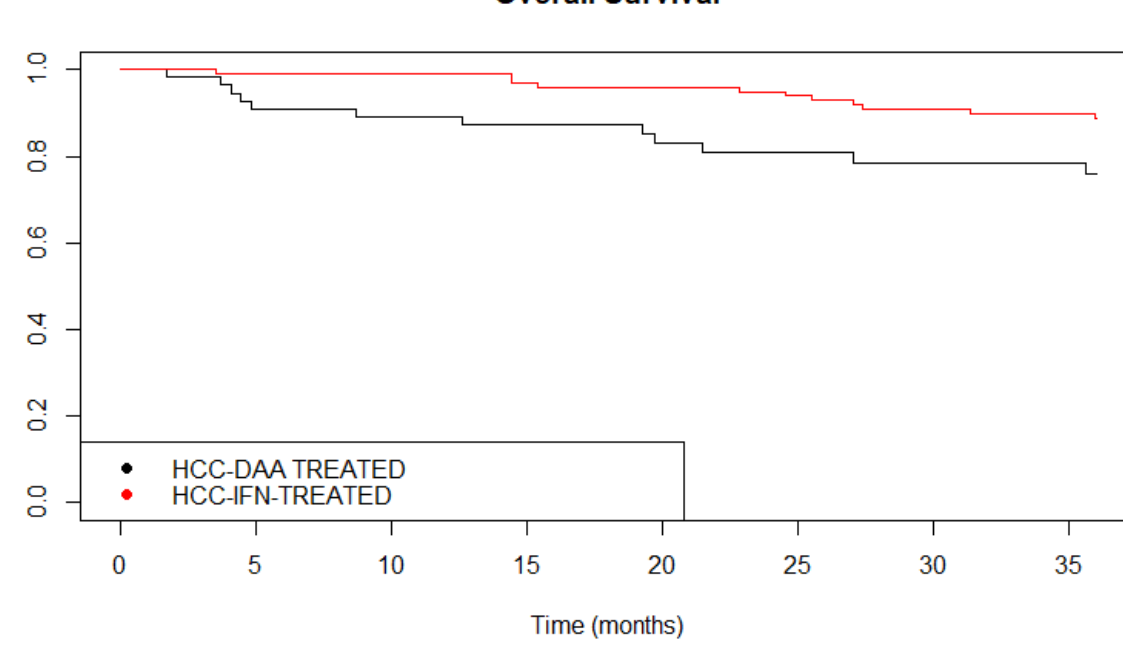
Figure 4. Kaplan–Meier 3-year overall survival in DAA-HCC group vs. hHCC group. Kaplan–Meier analysis of patients’ overall survival in historical IFN-treated group (non SVR) compared with overall survival of patients in DAA-treated group.